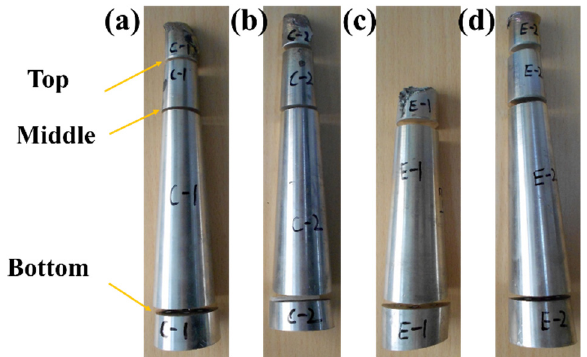
Figure 10. Flammability testing results and corresponding photos showing cutting locations of ( a , b ) as-cast GWK-a and GWK-c alloys; ( c , d ) as-extruded and aged (200 °C/64 h) GWK-a alloys.